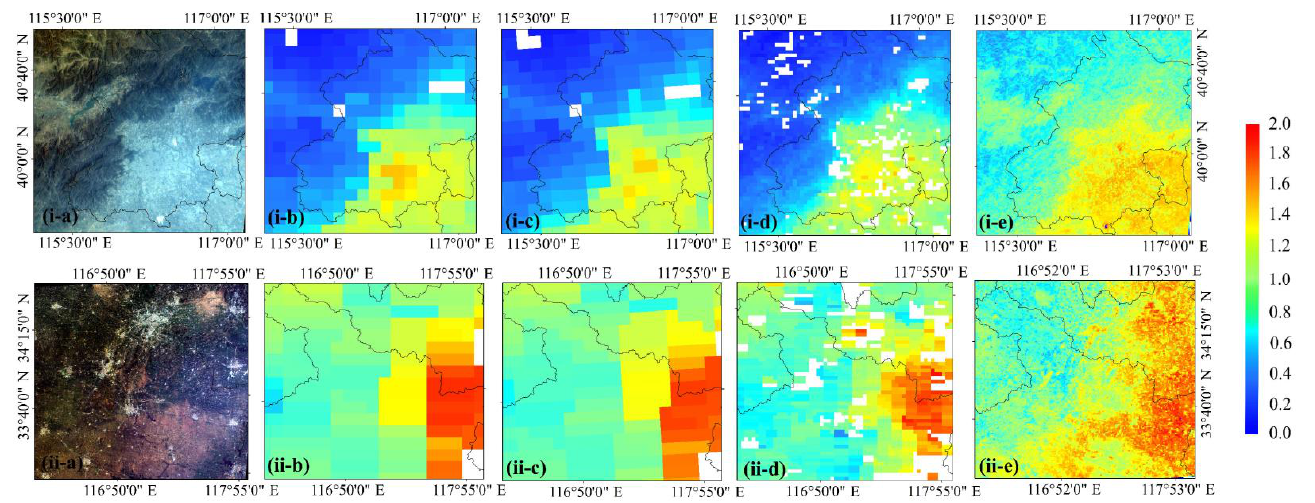
Figure 2. ( a ) Standard false color images, and spatial distributions of ( b ) MOD04C6.1 DB (10 km), ( c ) DT (10 km), ( d ) DT (3 km), and ( e ) our new (1 km) AOD data sets for ( i ) on 4 October 2018 over Beijing, and ( ii ) on 8 September 2018 over Xuzhou.